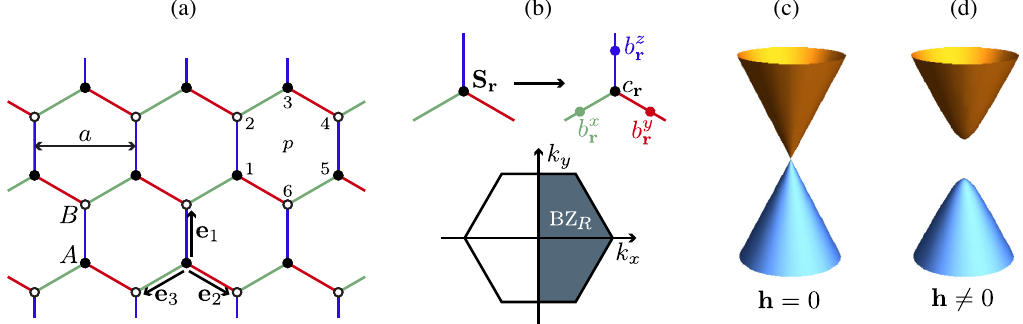
FIG. 1. (a) Lattice structure for the Kitaev honeycomb model. Spins exhibit bond-dependent nearest-neighbor interactions, with the x , y , and z components, respectively, coupling along green, red, and blue bonds. Vectors e 1 point from the A sublattice (solid circles) to ; 2 ; 3 the B sublattice (open circles). (b) Sketch of the Majorana-fermion representation of the spin operators [Eq. (4)] used for the exact solution. The b x;y;z r operators combine to form a Z 2 gauge field, while the c r operators define itinerant Majorana fermions that hop between nearest-neighbor sites. Hermiticity of the c r ’ s allows the kinetic energy to be expressed as a sum over momenta in the right half of the Brilllouin zone (BZ , shaded region). (c) In the gapless spin-liquid phase, the fermionic spectrum features a single massless Dirac R cone. (d) Breaking time-reversal symmetry via an applied magnetic field opens a gap at the Dirac point, generating a non-Abelian spin- liquid